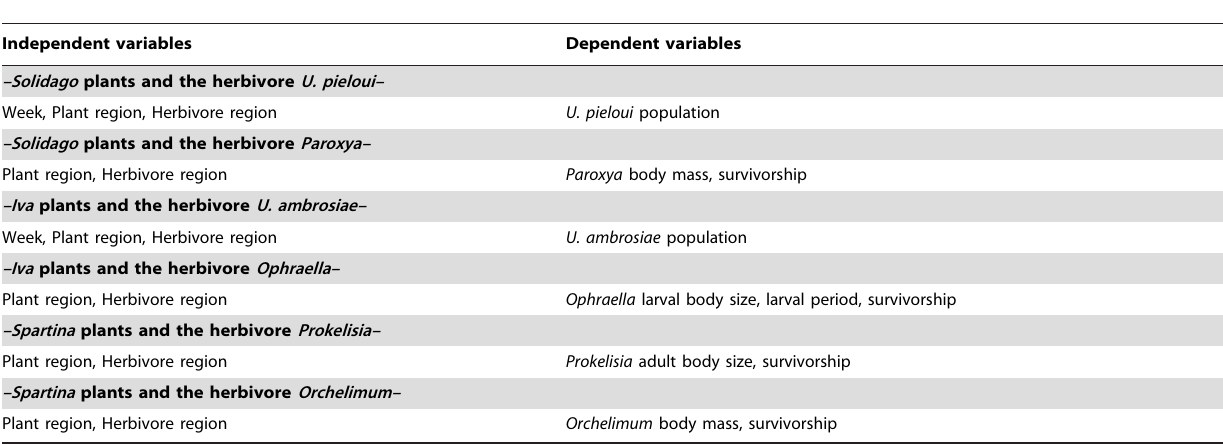
Table 3. The independent and dependent variables for the study of herbivore